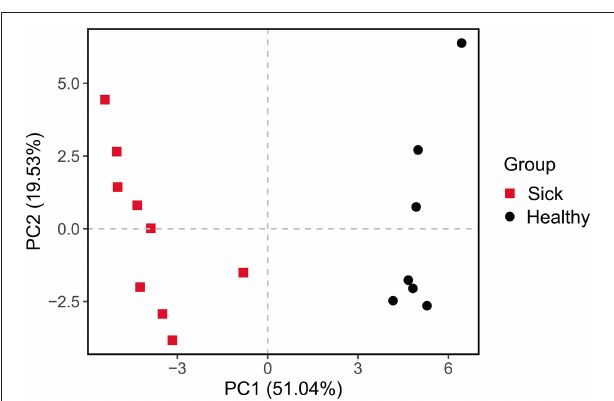
FIGURE 5 | Principal components analysis (PCA) of function of the crocodile lizard cutaneous bacteria. Numbers inside the parenthesis in the axis label show the percentage variation explained by each PC. Function was predicted at level 2 of the KEGG